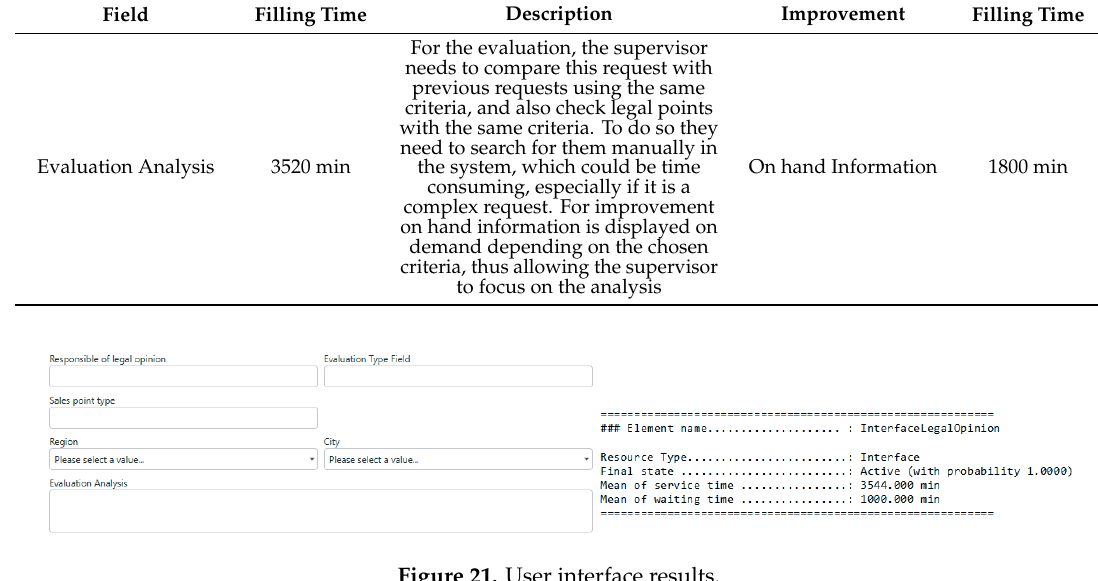
Figure 21. User interface results.